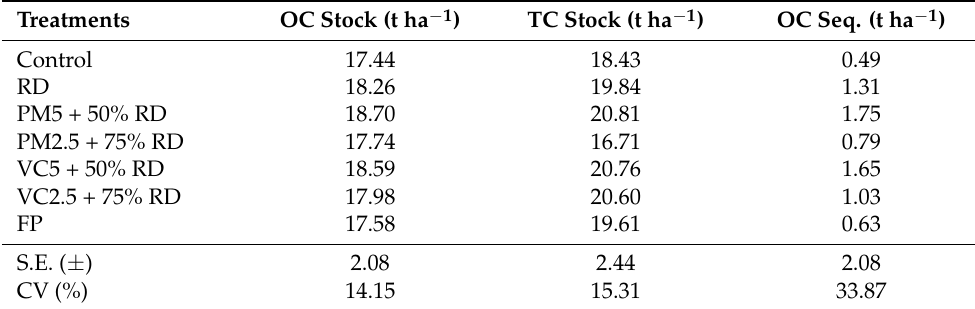
Table 5. Effects of poultry manure, vermicompost, and inorganic fertilizers on bulk density, carbon stock, and carbon sequestration in post-harvest